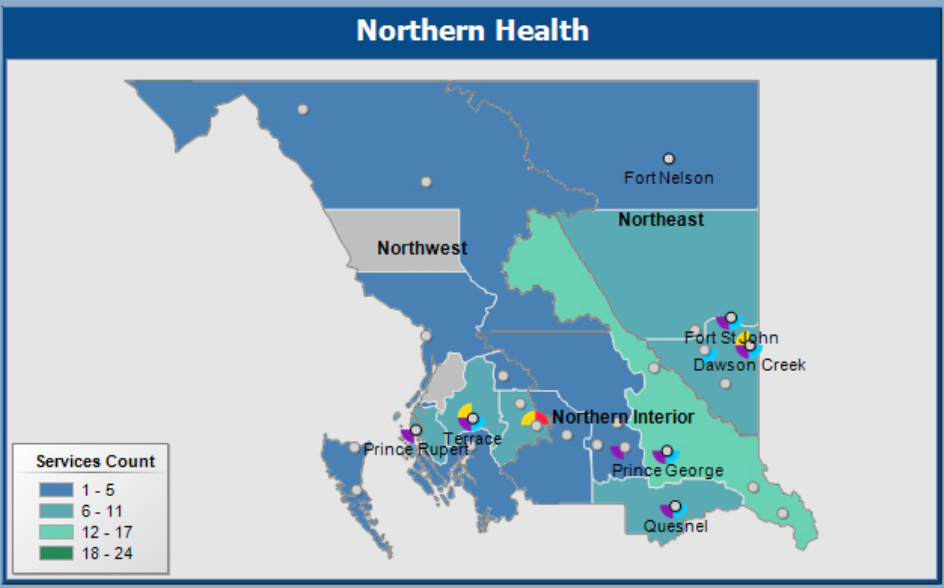
Figure 10. Available